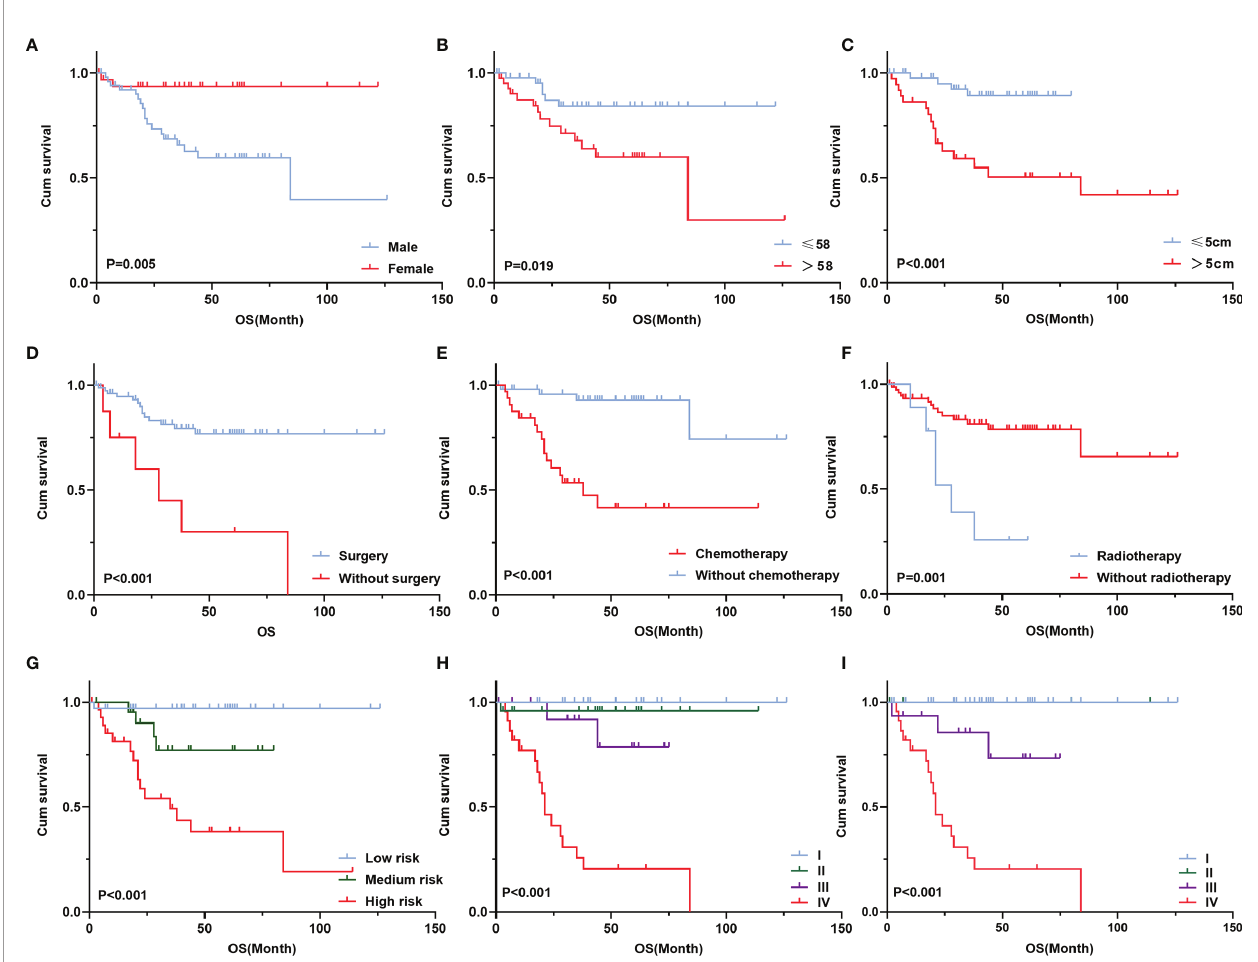
FIGURE 2 | Survival curve of different prognostic factors of 84 patients with TETs. Cumulative survival according to completion of sex (A) , age (B) , maximum tumor diameter (C) , surgery (D) , chemotherapy (E) , radiotherapy (F) , WHO histological classi fi cation (G) , Masaoka – Koga stage (H) , and 8th UICC/AJCC TNM staging (I) .